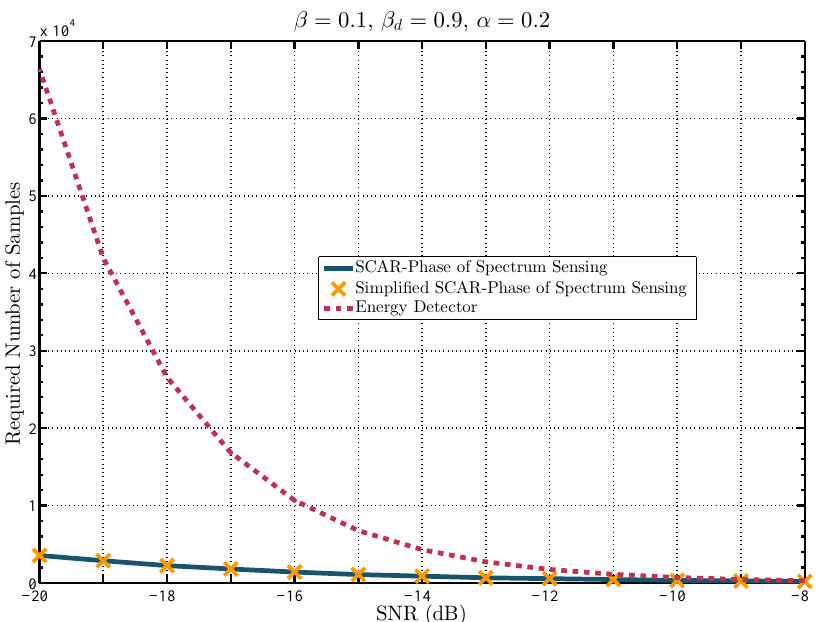
Figure 8. Comparison of the required number of samples to achieve a probability of detection ρ d = 0.9 for a target probability of false alarm ρ = 0.1 for different spectrum sensing schemes.